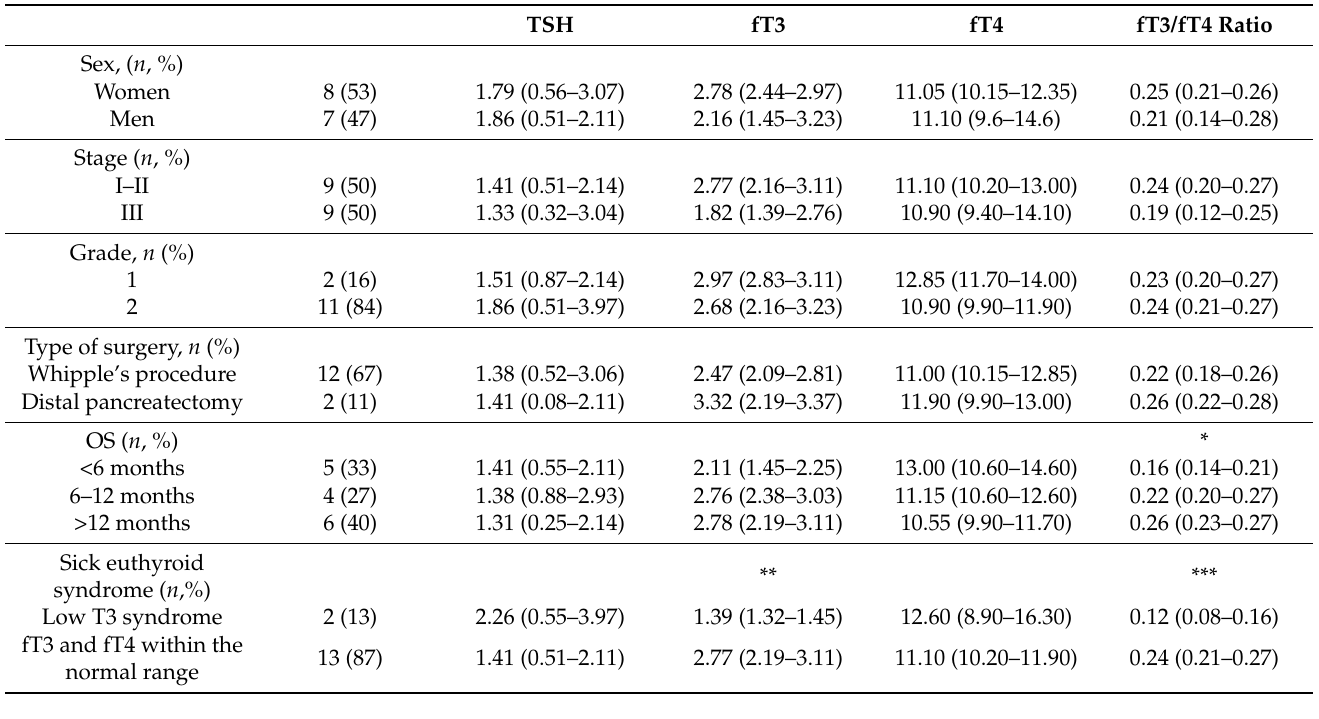
Table 2. TSH, fT3, fT4 concentrations and fT3/fT4 ratio according to selected clinical features: median